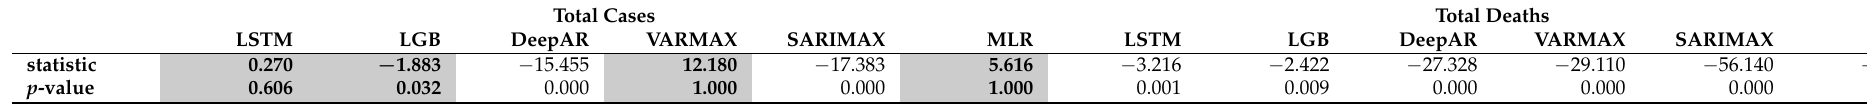
Table 13. Student’s t-test for Forecast sMAPE (H 0 : Benchmark Forecasts Outperform MES-LSTM).